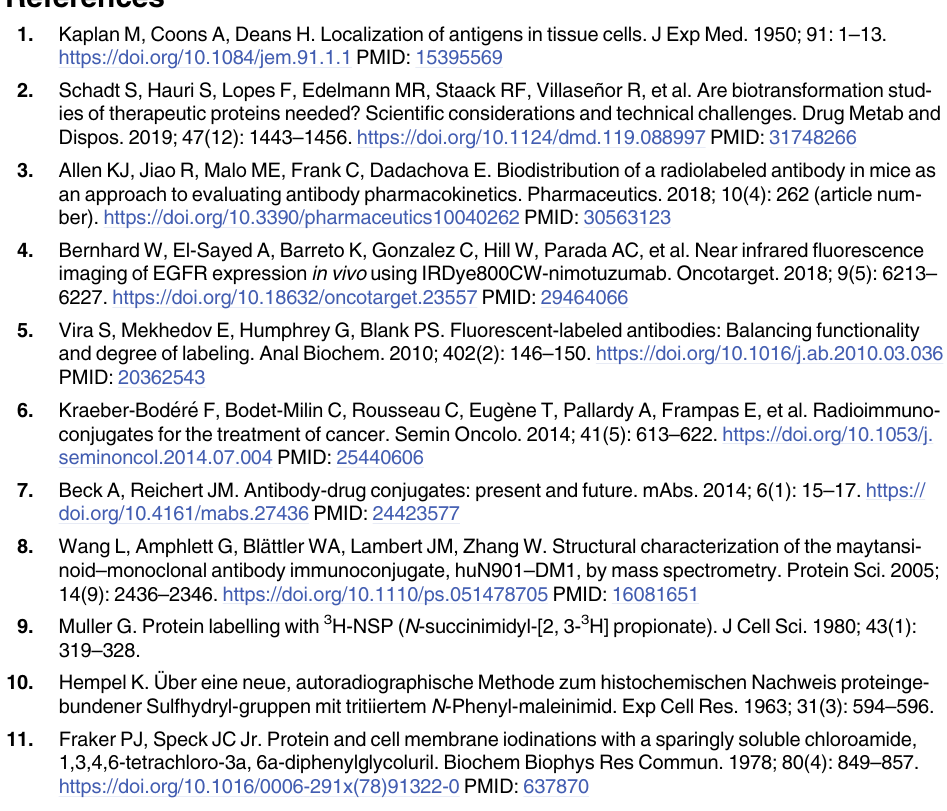
X-axis: time in min; left Y-axis: absorbance at 280 nm in black; right Y-axis: absorbance at 494 nm in green. (PDF) S3 Fig. Chromatograms of mAbB5 to mAbB7 from the mAb ter column: FcRn affinity chromatography; right column: heparin affinity chromatography. X- axis: time in min; left Y-axis: absorbance at 280 nm in black; right Y-axis: absorbance at 494 nm in green.